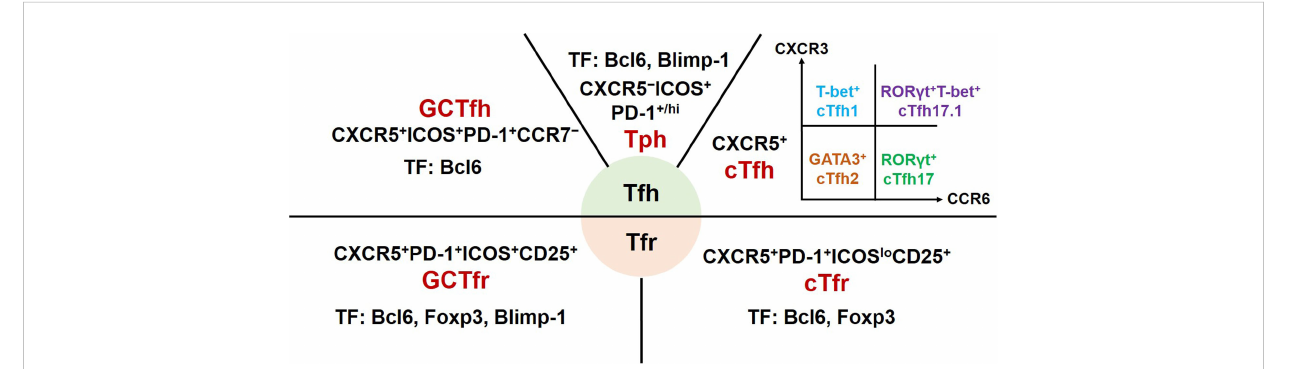
FIGURE 1 Phenotype and transcription factors of Tfh effector cell subsets and Tfr cells. GC, germinal centers; Tfh, T follicular helper; cTfh, circulating Tfh; Tph, T peripheral helper; Tfr, T follicular regulatory; cTfr, circulating Tfr; CXCR, chemokine receptor; ICOS, inducible T-cell co-stimulator; PD-1, programmed cell death protein-1; Bcl6, B cell lymphoma 6; Foxp3, forkhead box P3; GATA3, GATA-binding protein 3; ROR, retinoid-related orphan receptor; Blimp-1, B lymphocyte-induced maturation protein 1; TF, transcription